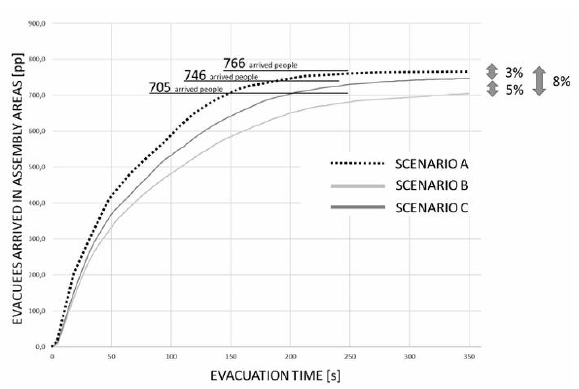
Figure 6. Evacuation curve comparison in the three scenarios.